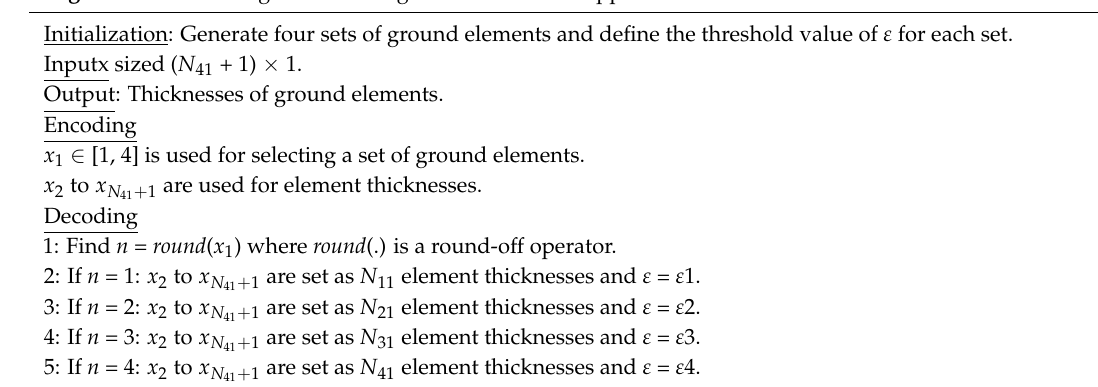
Algorithm 1. Encoding and decoding scheme for a MG